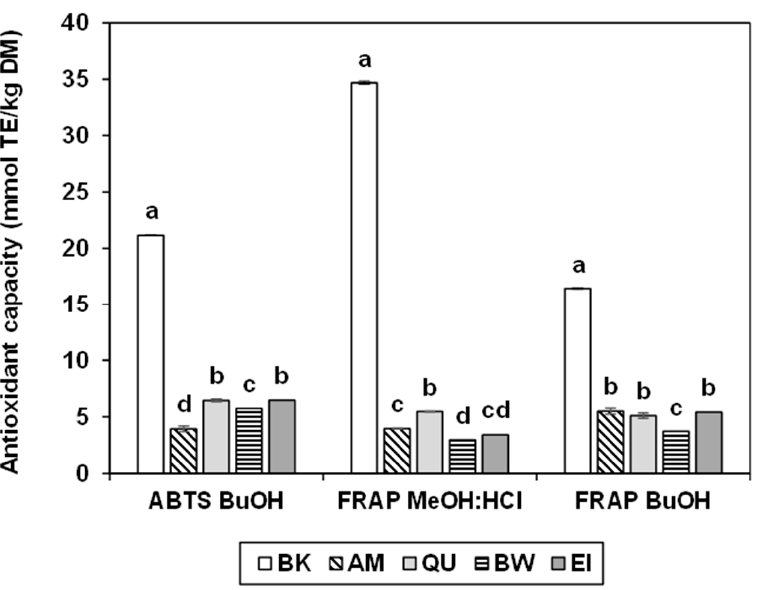
Figure 2. Antioxidant capacity tested by the ABTS and FRAP methods, of the buckwheat (BK), amaranth (AM), quinoa (QU), bread wheat (BW) and einkorn (EI) wholemeal. The error bars represent the standard deviation; different letters indicate significant differences ( p < 0.05) among samples.